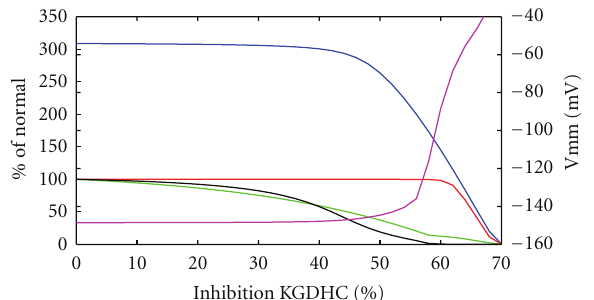
Figure 6: System characteristics under KGDHC inhibition. ATP production rate (red), NADH level (green), mitochondrial mem- brane potential (magenta, right scale), and reduced cytochrome c level (black) at normal ATP demand versus increased inhibition of KGDHC, maximal ATP production capacity in blue. Values except membrane potential normalized to reference state without inhibition. Figure 7: Mitochondrial membrane potential characteristics at inhibition of KGDHC. Mitochondrial membrane potential versus the ATP production rate at di ff erent inhibition levels of KGDHC. Dotted line: − 80 mV membrane potential